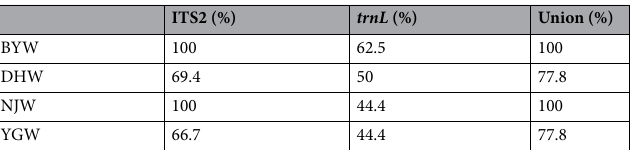
Table 7. The sensitivity of prescribed herbal materials for four TCM preparations based on ITS2 and trnL biomarker. Note that the sensitivity was defined as the ratio of the detected prescribed herbal materials and the prescribed herbal materials that could be detected in